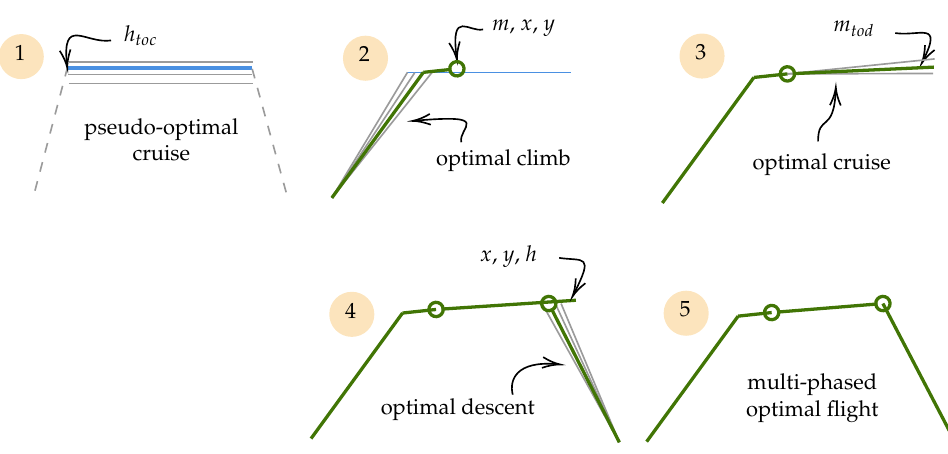
Figure 3. Steps to obtain the multiphase optimal flight (flight phases not to scale). First, the top of climb altitude is found based on the pseudo-optimal cruise trajectory. The optimal climb is generated based on this final altitude. After that, the actual optimal cruise trajectory is obtained based on the final location and mass of the climbing trajectory. The optional descent trajectory is also found based on the altitude and position at the end of the cruise. Finally, the complete trajectory is obtained from the intersection of all phase